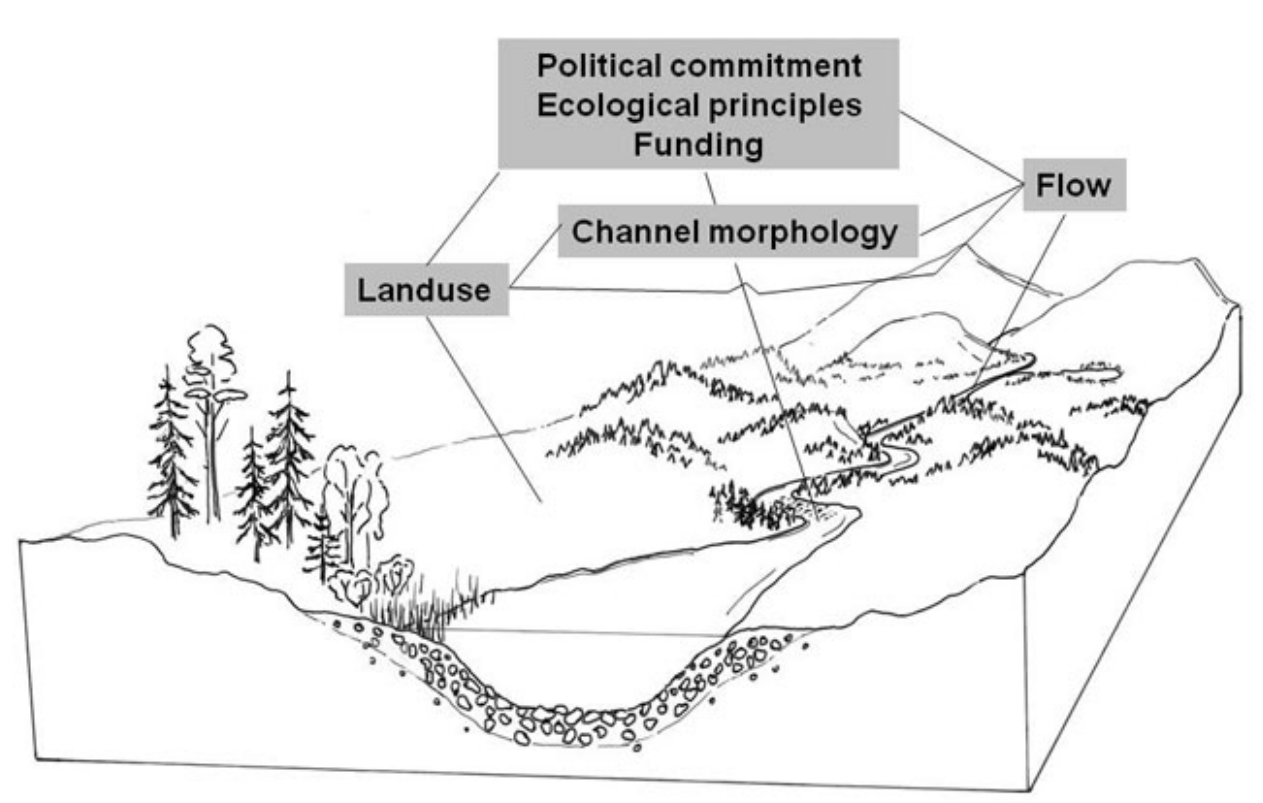
Fig. 3. Major management actions required to reduce the risk for unfavorable water quality situations fall into three major categories at the catchment scale. If political incentive, knowledge, and funding are available, management should focus primarily on modifying land use, channel morphology, and